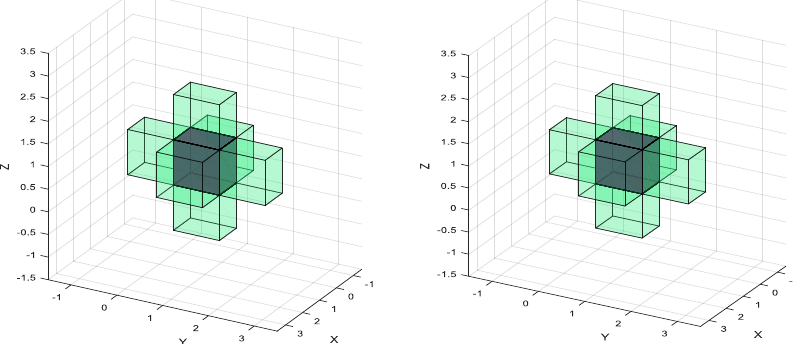
Figure 2. View of expanded voxels (6−sided search vs. 18−sided search).